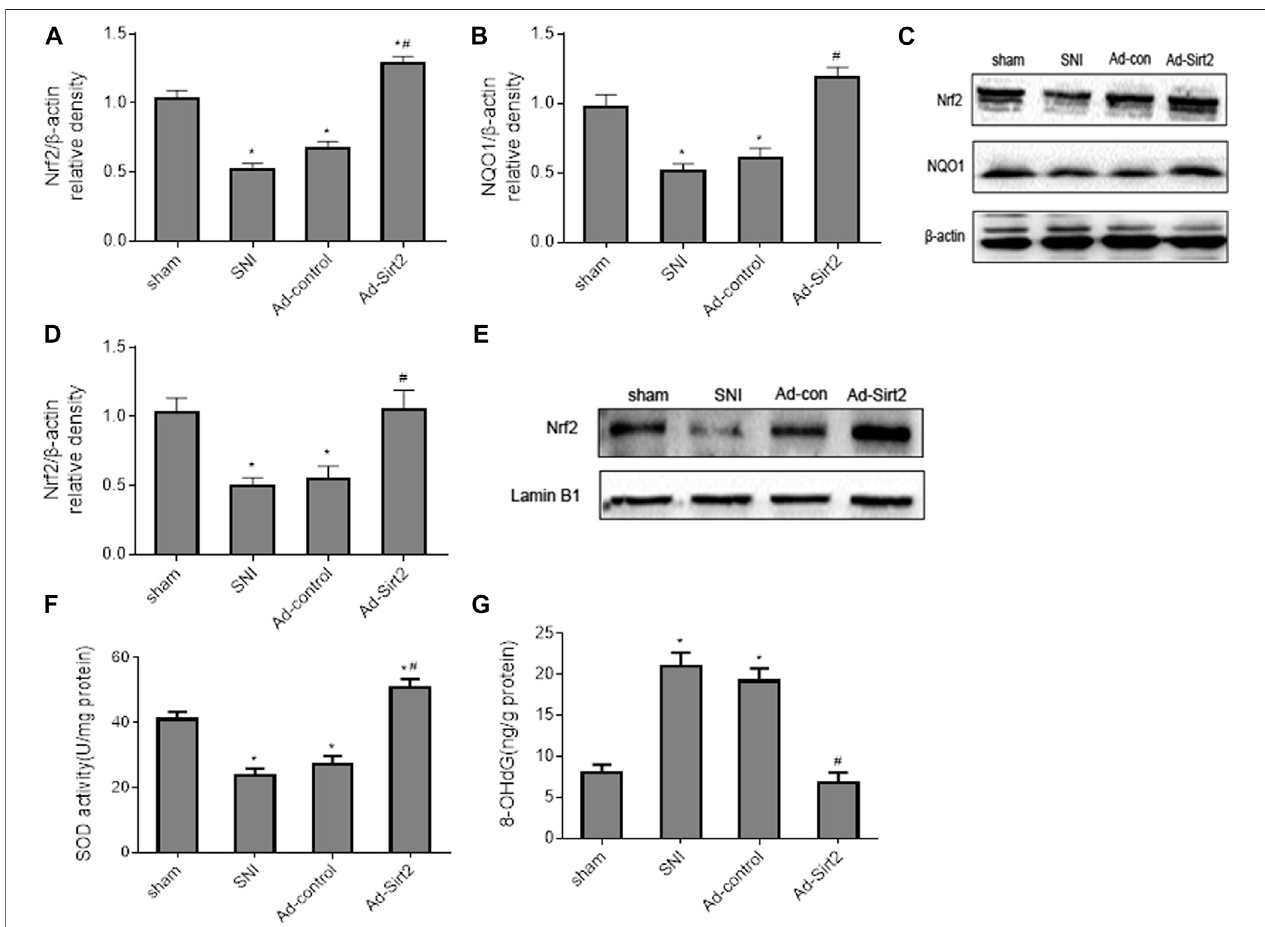
FIGURE9|(A – C) :EffectsofintrathecalinjectionofAd-Sirt2orAd-controlonexpressionofNrf2anditsdownstream targetNQO1inthewholetissuelysatesofthe spinal cord in SNI rats. (D,E) : Effects of intrathecal injection of Ad-Sirt2 or Ad-control on expression of Nrf2 in the nuclear fractions of the spinal cord in SNI rats. (F,G) : Effects of intrathecal injection of Ad-Sirt2 or Ad-control on levels of antioxidant enzyme superoxide dismutase (SOD) and oxidative stress marker 8-hydroxy-2 ′ - deoxyguanosine(8-OHdG)inthespinalcordofSNIrats.Shamratswithouttreatmentservedascontrol.Valuesareexpressedasmean ± SE(n (cid:1) 5foreachgroup). * p < 0.05 vs sham; # p < 0.05 vs SNI or